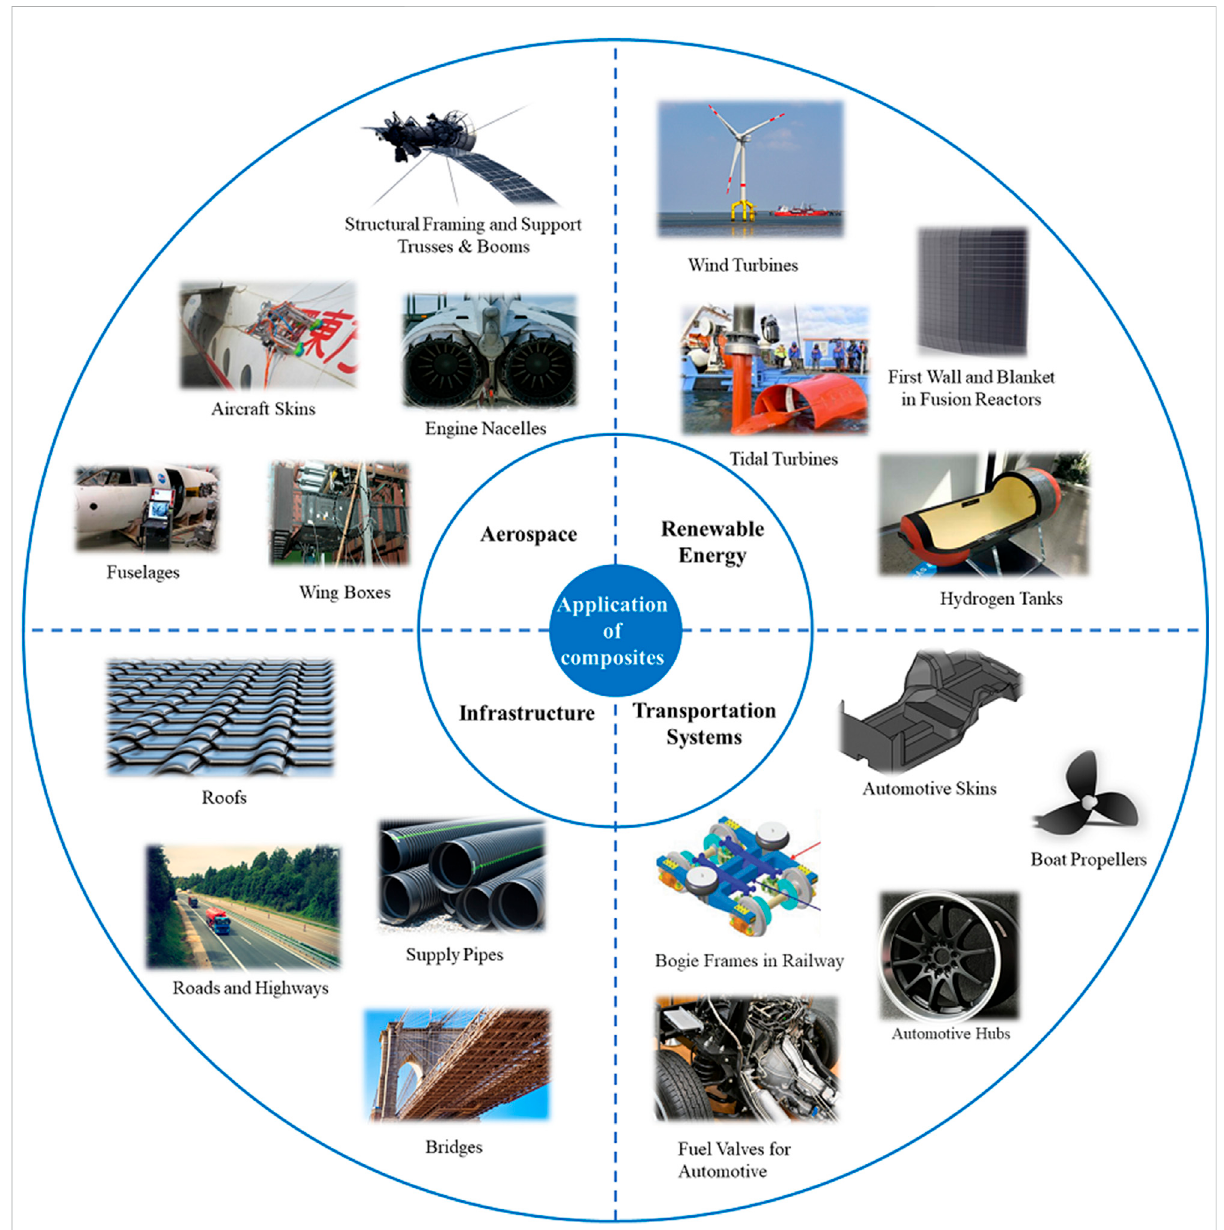
FIGURE 1 Application of composites in the areas of aerospace, renewable energy, transportation systems, and infrastructure. Photos were reproduced with permission from (Jeon et al., 2011; James et al., 2014; Martensson et al., 2017; Jiang and Wang, 2019; Towsyfyan et al., 2020; Laaouidi et al., 2021; Alves et al.,